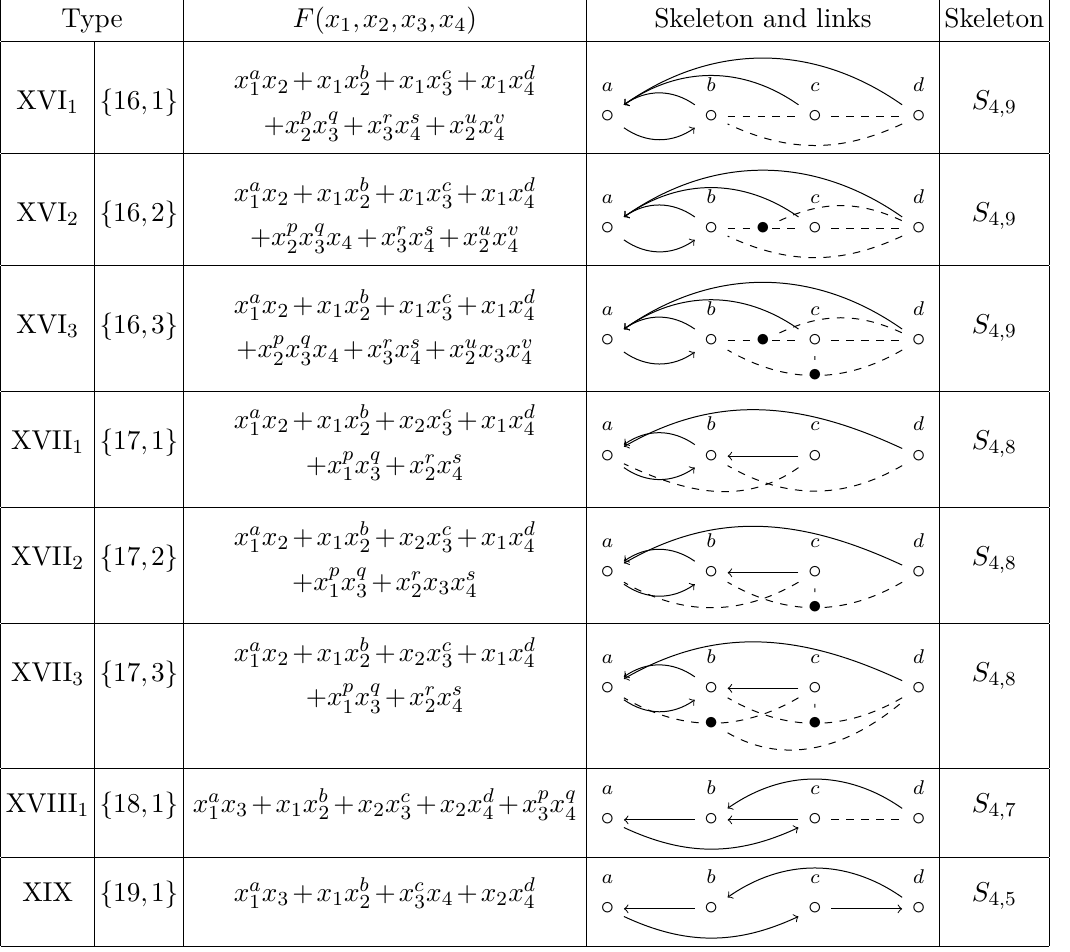
equation determined by the scaling weight q is the scaling weight of x